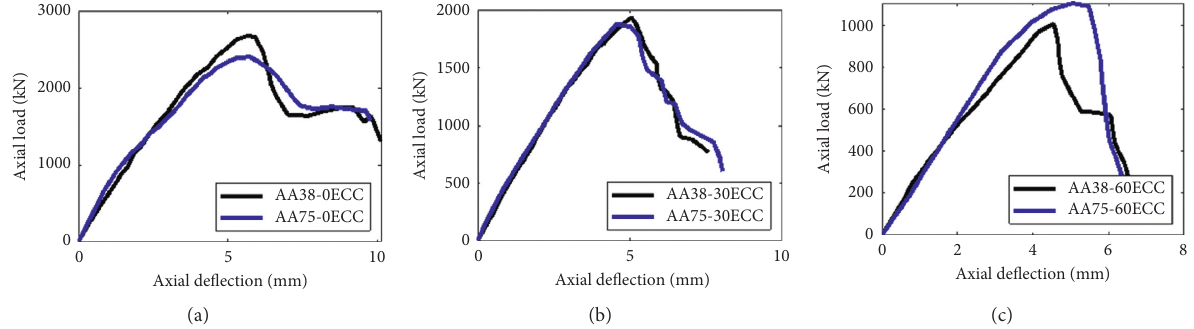
Figure 8: Effect of the pitch of spirals on the load-deflection response of GFHF columns.